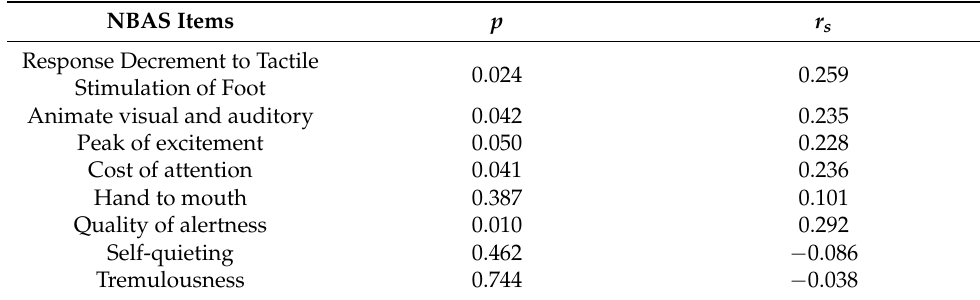
Table 2. Correlation between week of gestation (without division before or after the 37th week of gestation) and the items of the